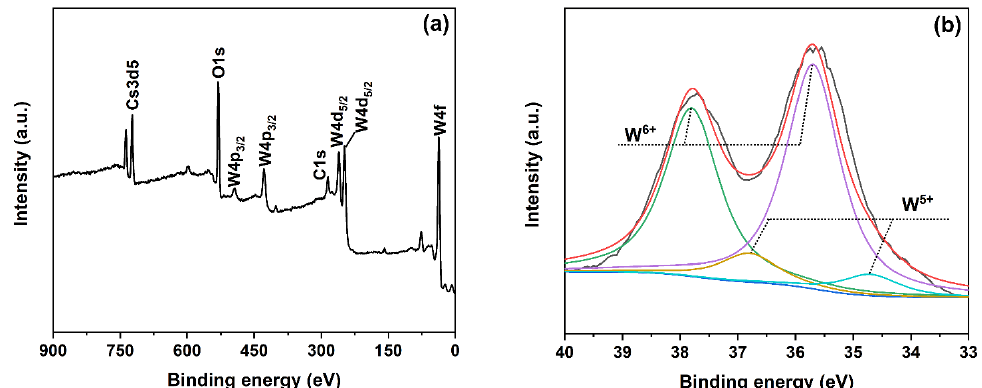
Figure 4. XPS spectra of Cs 0.3 WO 3 synthesized hydrothermally at 200 °C for 24 h using 0.18 mmol CsCl, 0.4 mmol WO 3 , 8.8 mmol CH 3 CH 2 CHO, 2.8 mmol NH 3 ‧ H 2 O and 5.0 mmol (NH 4 ) 2 SO 4 : ( a ) survey spectrum; ( b ) high-resolution spectrum of W 4f. The black and red lines are the experimental data and sum of fits, respectively; the green and purple lines are the fits of W 4f 5/2 and W 4f 7/2 for W 6+ , respectively; the yellow and blue lines are the fits of W 4f 7/2 and W 4f 5/2 for W 5+ ,